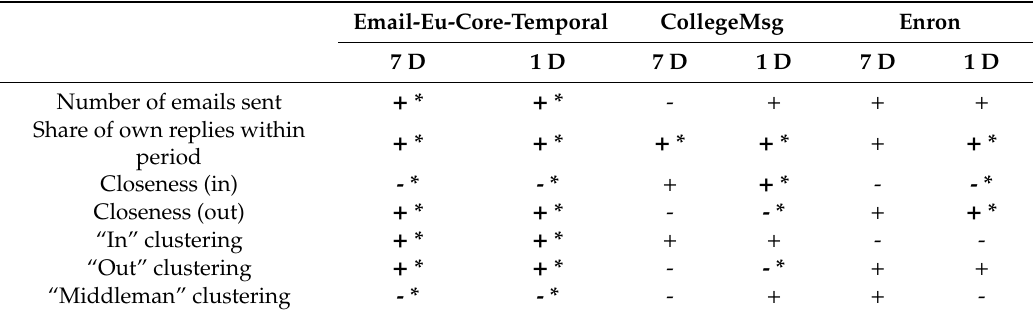
Table 10. Comparison of dependent variable direction of estimates, Extended Directional